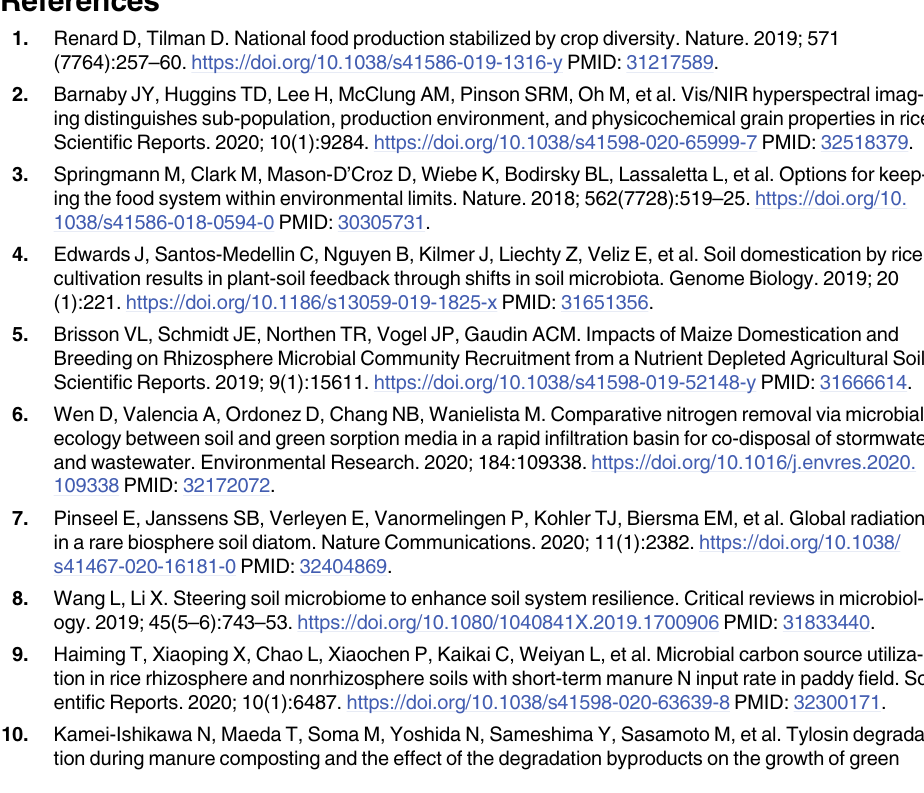
S1 Table. Characteristics of the MBC studies included in the meta-analysis. S2 Table. Characteristics of the Shannon index studies included in the